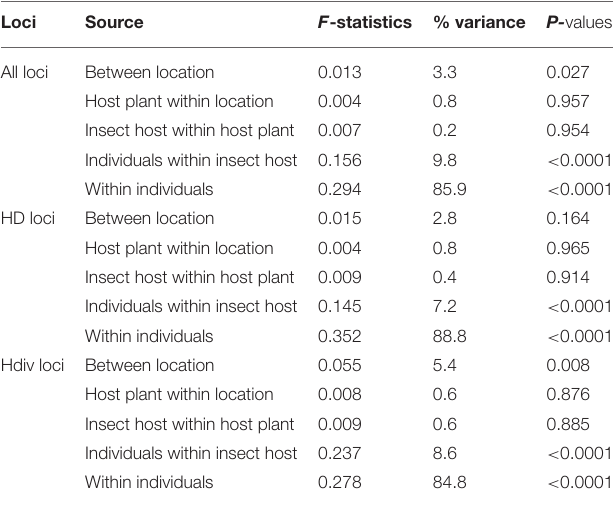
TABLE 2 | AMOVA analysis results. HD loci are located within Hyposoter didymator genome excluding viral sequences; Hdiv loci are within integrated viral